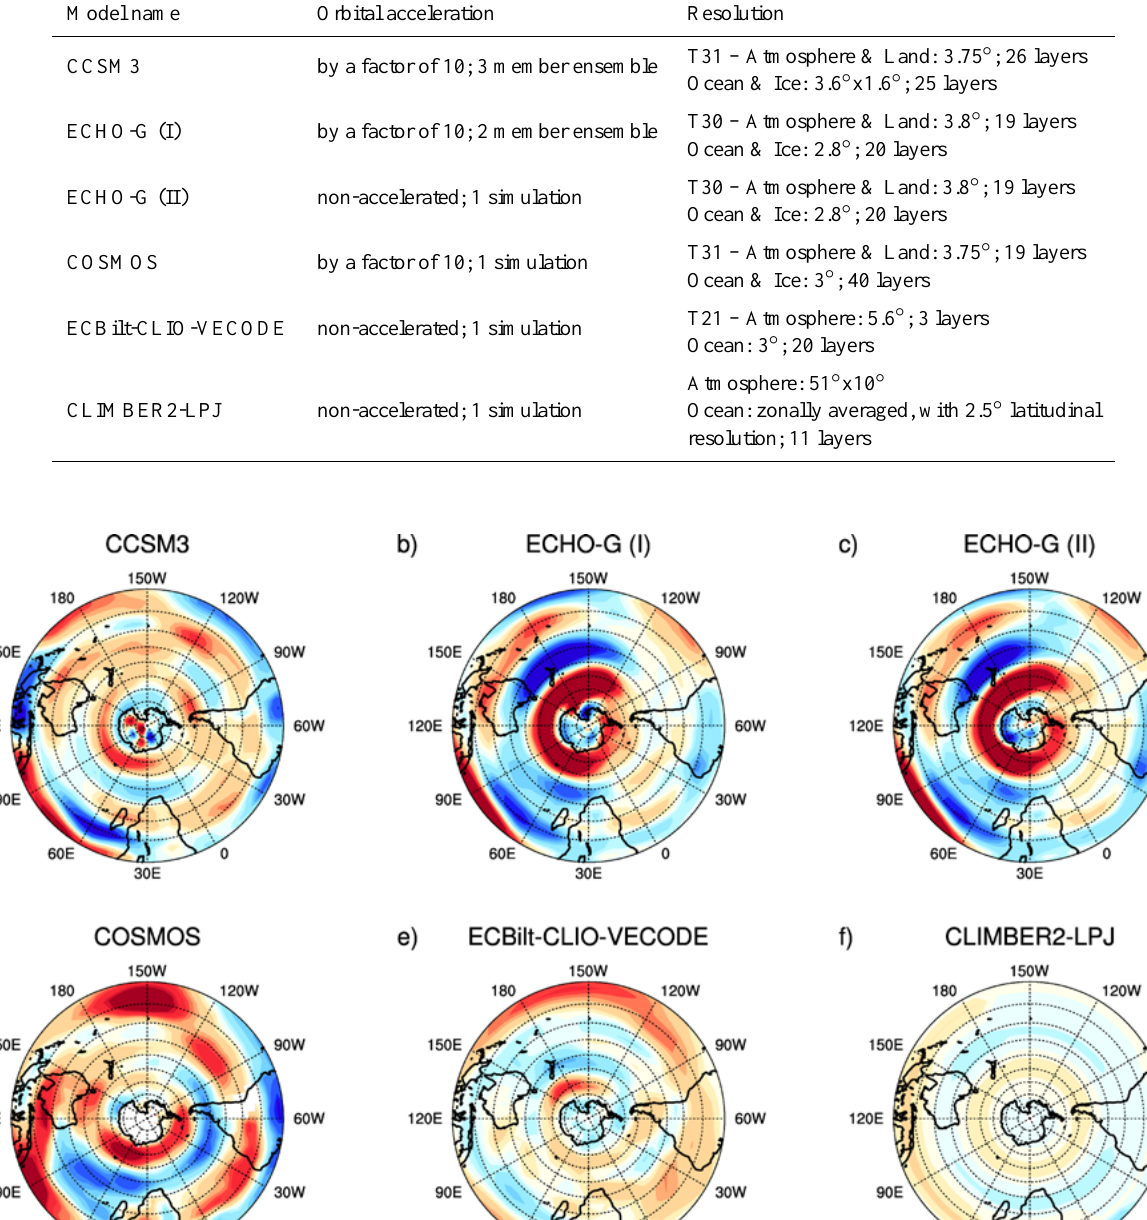
Table 1. Brief summary of the climate models used for inter-comparison.